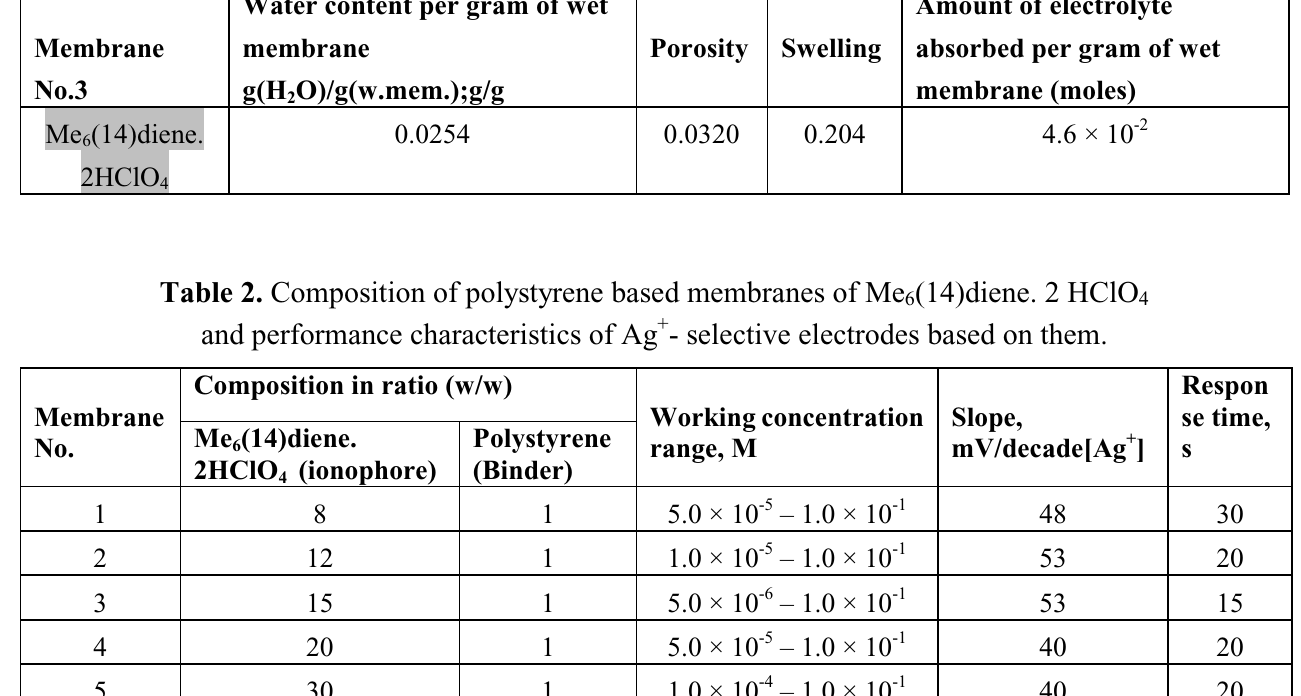
Table 1. Functional properties of polystyrene based membrane of macrocycle Me